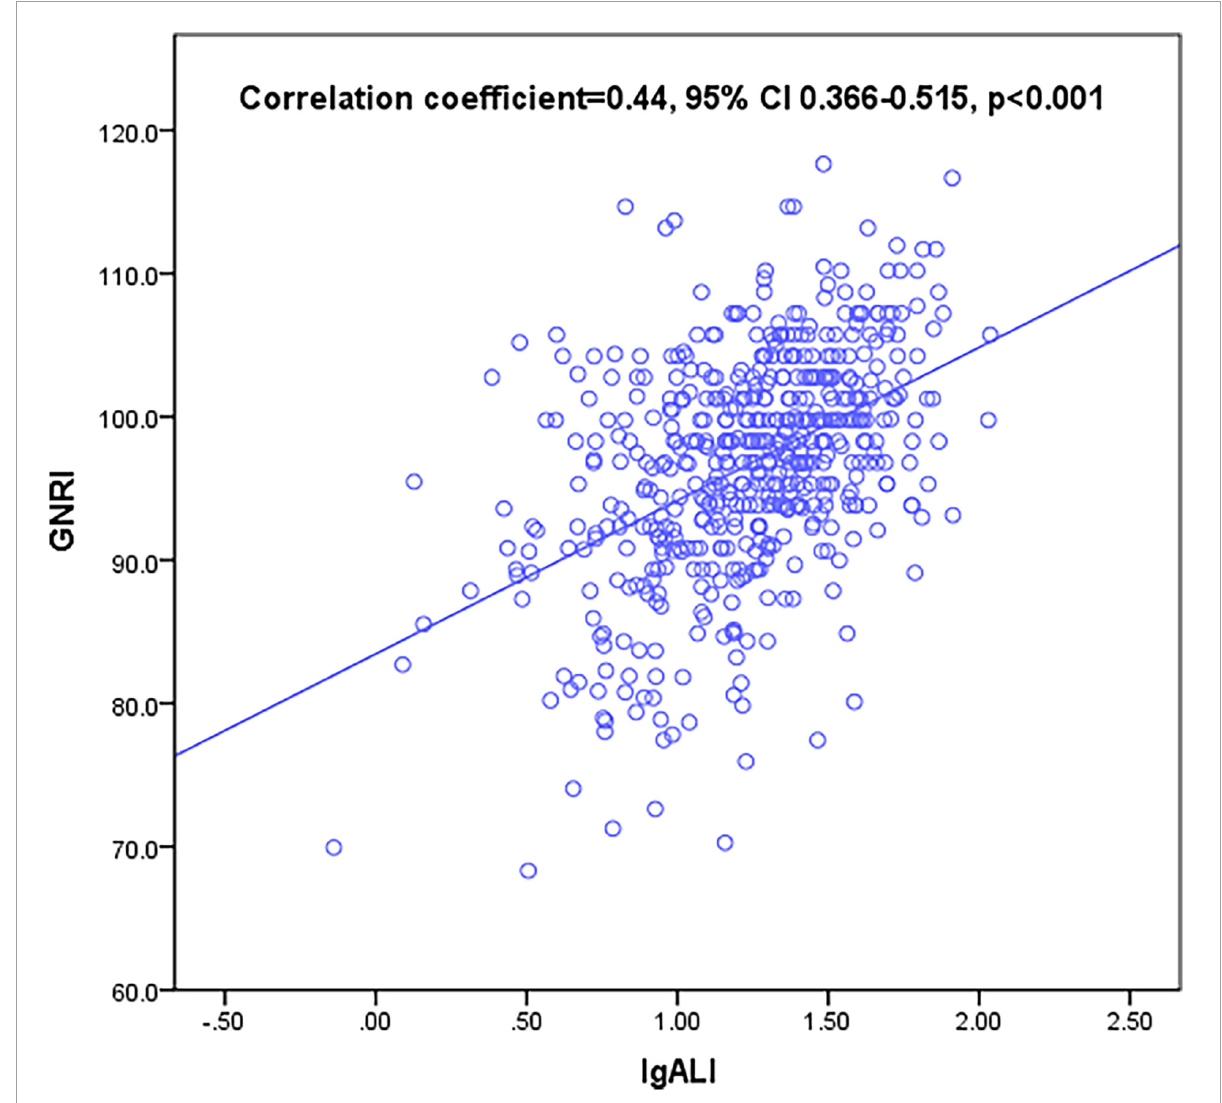
FIGURE2 Correlation between advanced lung cancer inflammation index (ALI) and geriatric nutritional risk index (GNRI). ALI was moderately correlated with GNRI (correlation coefficient = 0.44, 95% confidential interval (CI) 0.366–0.515, p < 0.001).